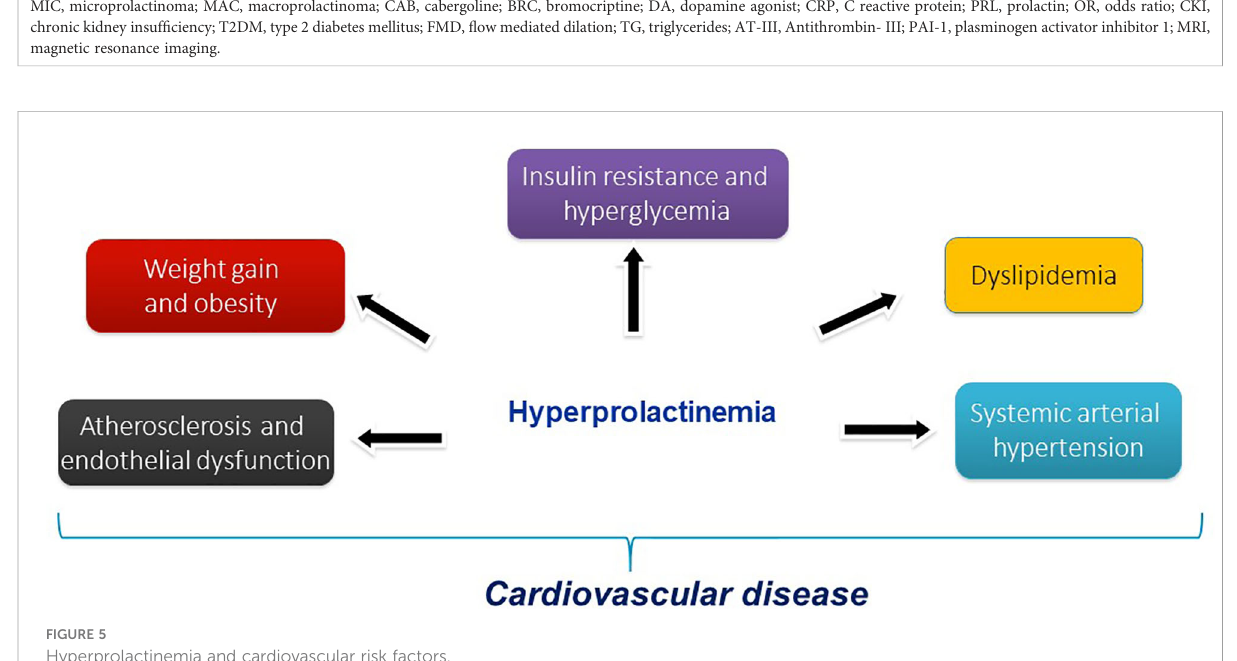
FIGURE 5 Hyperprolactinemia and cardiovascular risk